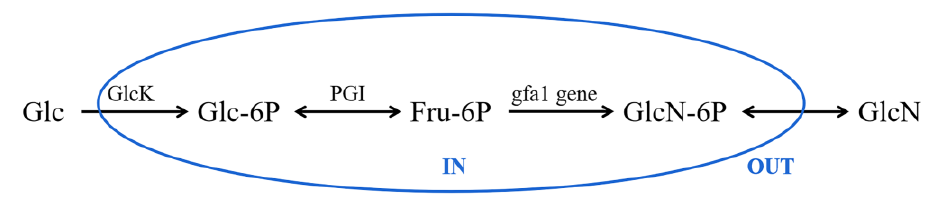
Figure 4. The putative biosynthetic pathway of glucosamine in C. militaris